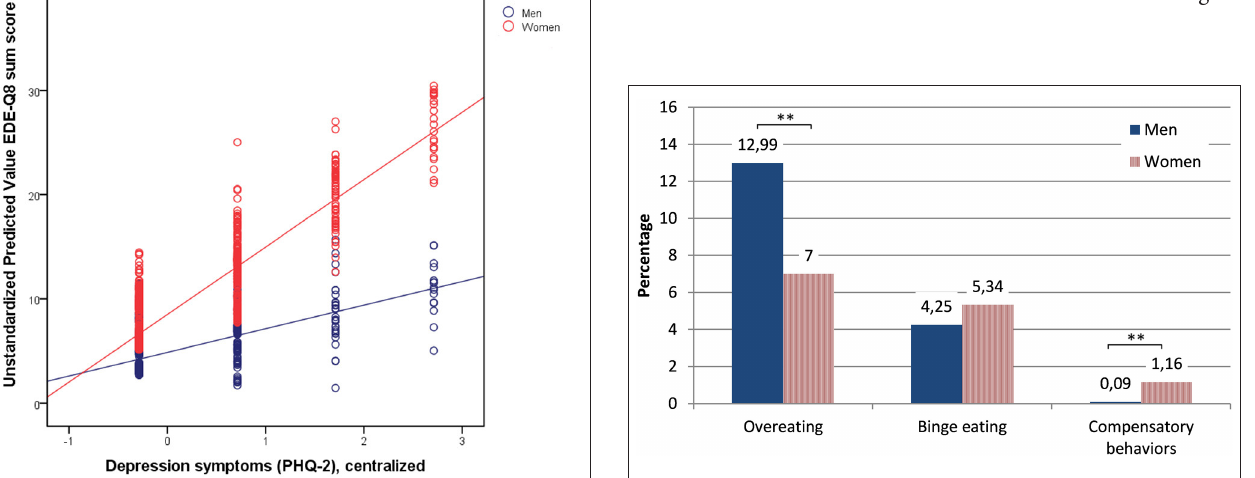
FIGURE 1 | Visualization of the interaction: there was a closer association of eating disorder symptoms as measured by the EDE-Q8 with depression symptoms as measured by the PHQ-2 in women.